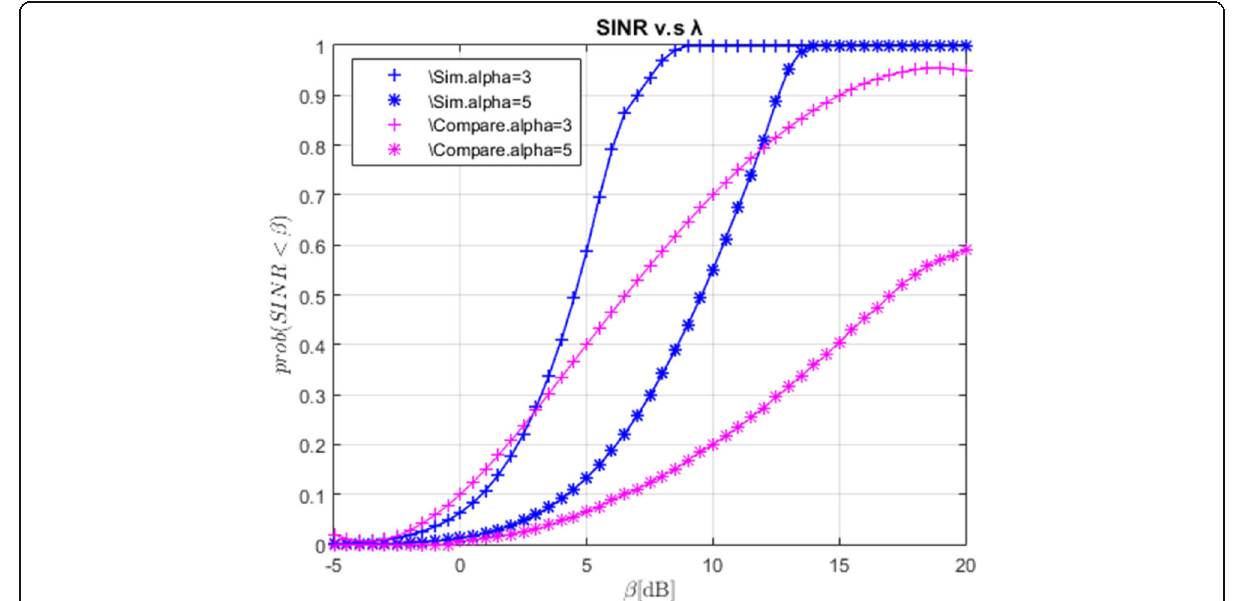
Fig. 6 CDF of SINR when λ BS = 14/km 2 and D = 300m